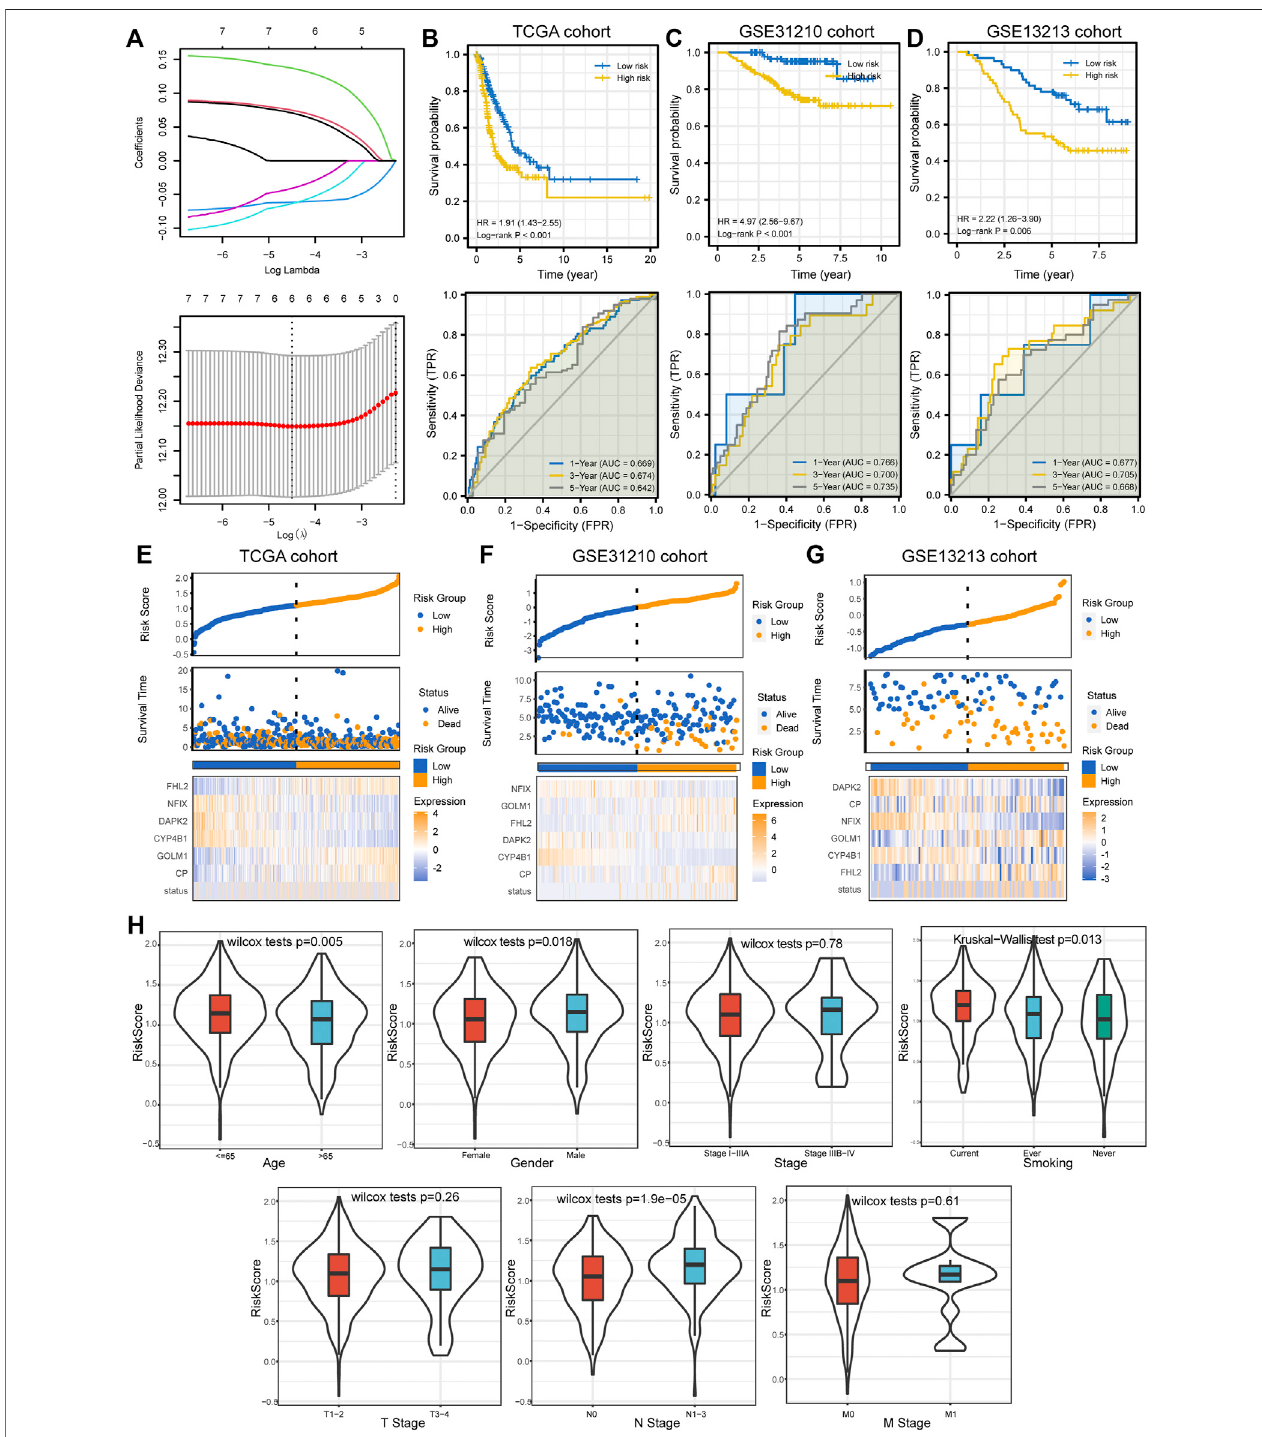
FIGURE 5 | Prognostic model establishment and validation for patients with LUAD. (A) Six DEGs were selected for multivariate analysis via LASSO regression analysis. (B – D) Survival curves and ROC curves evaluate the risk strati fi cation ability and predictive ability of the constructed risk model in the TCGA , GSE31210, and GSE13213 cohorts. (E – G) Risk plots to illustrate the survival status of each sample in the TCGA , GSE31210, and GSE13213 cohorts. (H) The relationship between risk score and common clinicopathological characteristics of LUAD. LUAD, lung adenocarcinoma; DEGs, differentially expressed genes; LASSO, Least Absolute Shrinkage and Selection Operator; ROC, receiver operating characteristic curve; TCGA, The Cancer Genome Atlas.